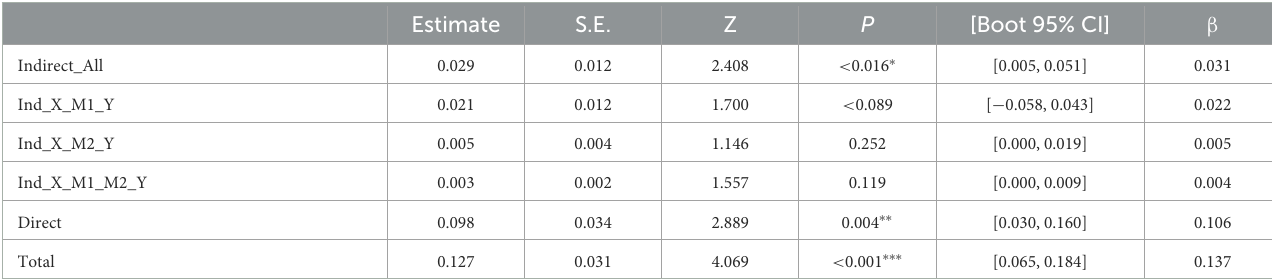
TABLE 3 The indirect paths between parental depression and internalizing and externalizing problems through parenting stress and child maltreatment ( n = 855). Estimate